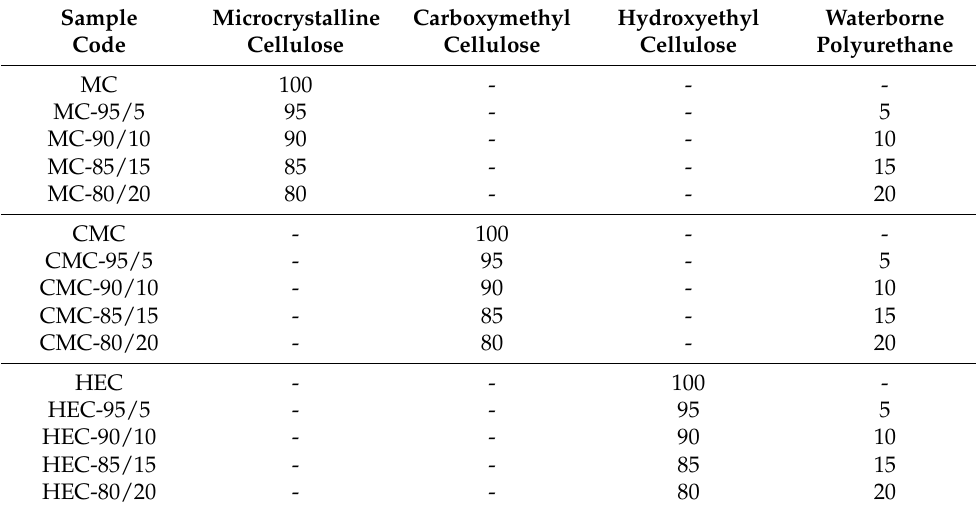
Table 1. The formulation of cellulose/WPU composite hydrogels (weight by parts). Sample